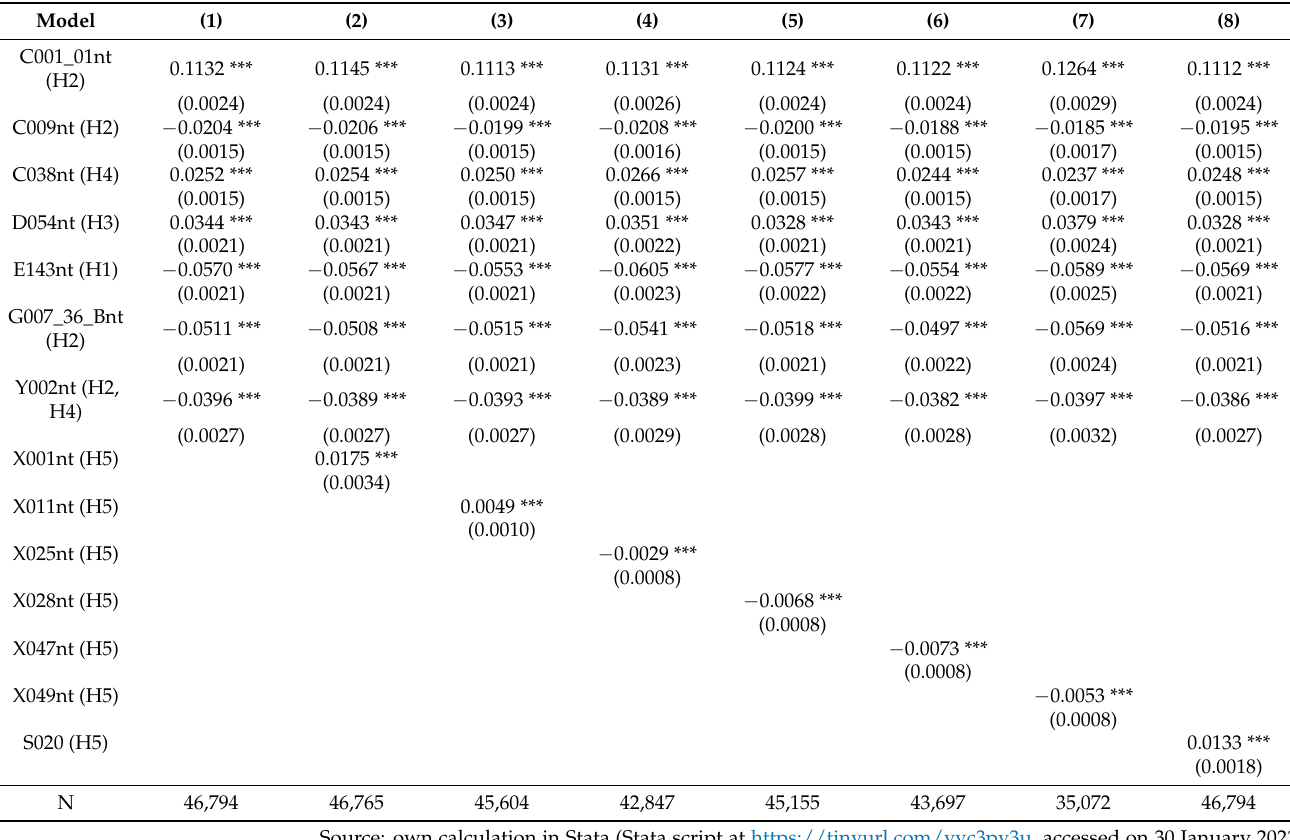
Table A7. The average marginal effects identified after controlling using the most relevant seven predictors (hepta-core) and each of the other seven most significant socio-demographic control variables in logit